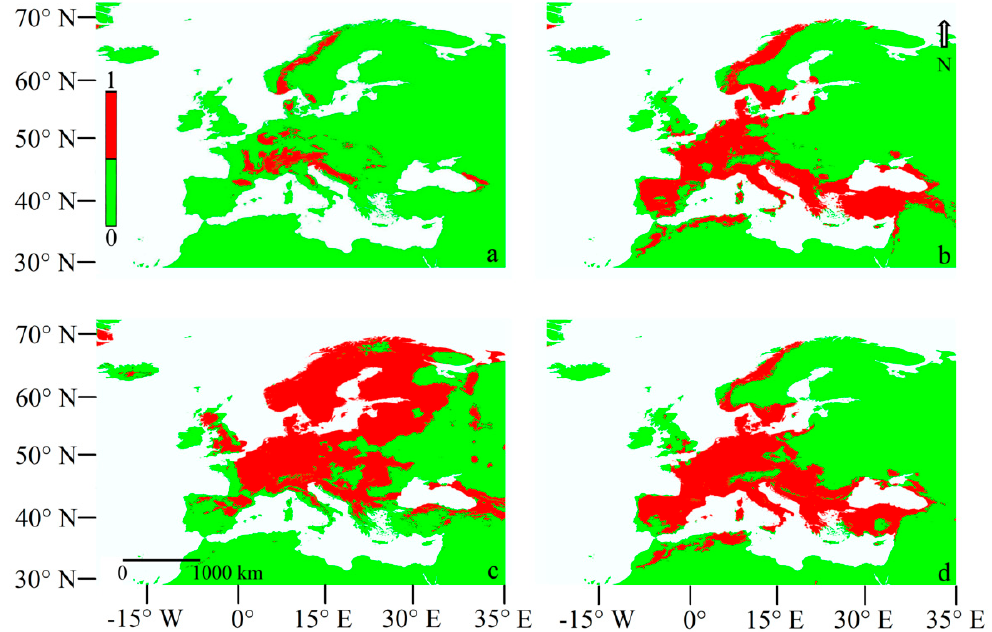
Figure 4. Ecological Niche Models for P. mugo/uncinata ( a ), P. nigra ( b ), P. sylvestris ( c ) and Q. pubescens ( d ) using the current scenario. Binary map shows: 0 = unsuitable habitat; 1 = suitable habitat.